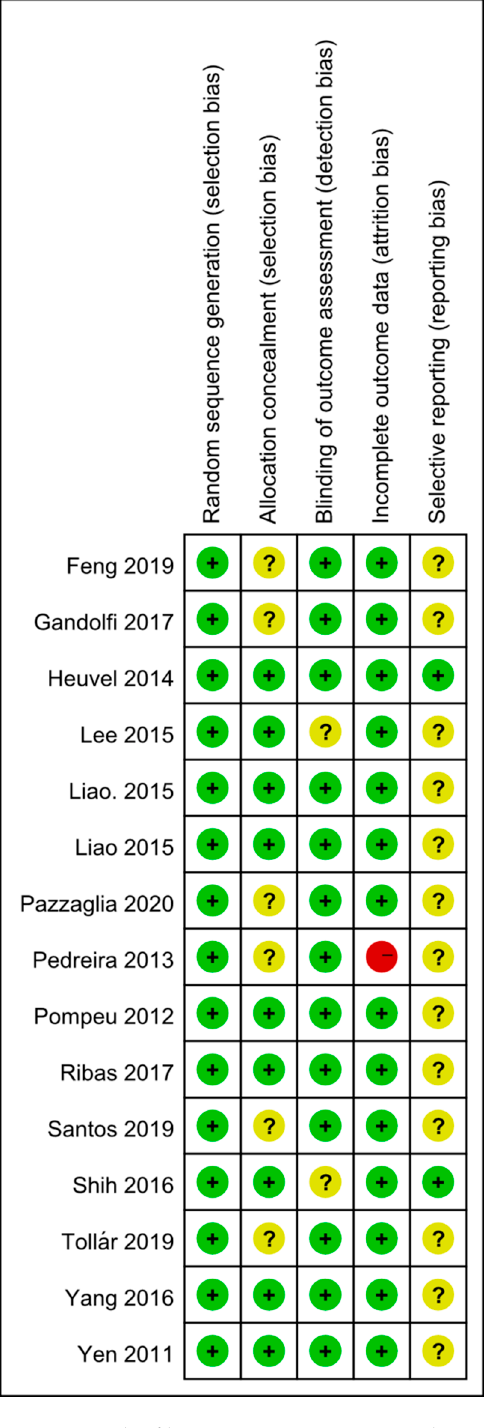
Figure 3. Risk of bias summary: review authors’ judgements about each risk of bias item for each included study.